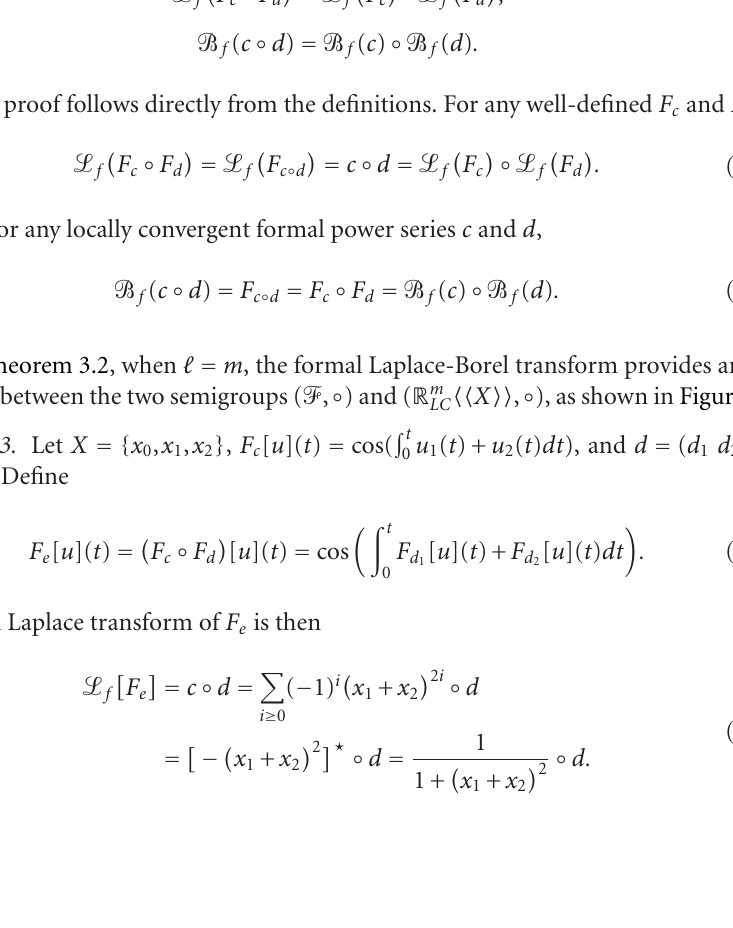
Fliess operators is always another Fliess operator with generating series c ◦ d , that